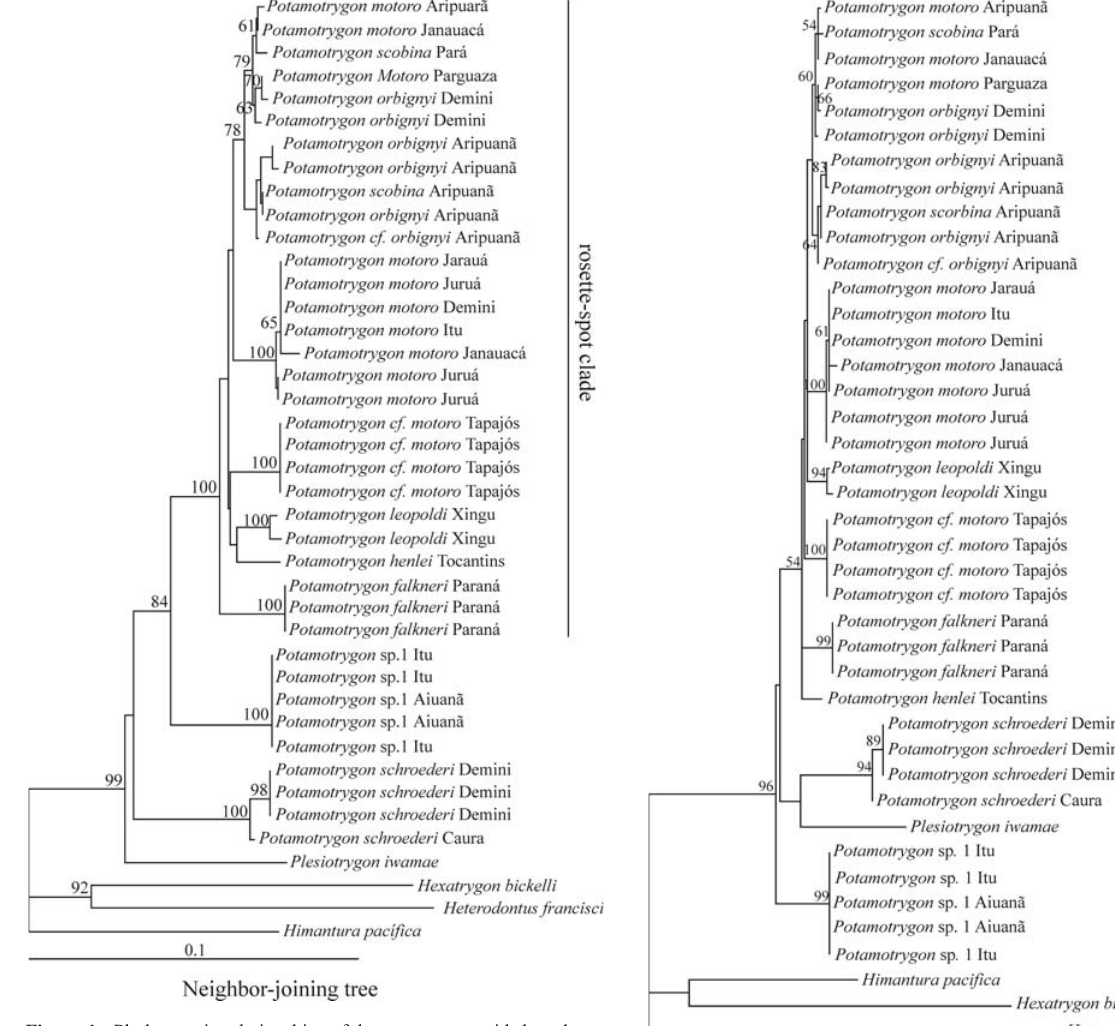
Figure 1 - Phylogenetic relationships of the potamotrygonids based on a Neighbor-Joining analyses of mitochondrial COI sequence data using K2P substitution model. Bootstrap values less than 50% were not shown. Plesiotrygon iwamae appears sister to all species of Potamotrygon . P. motoro , P. scobina , and P. orbignyi are non-monophyletic. The relation- ships among species of rosette-spot group are not well supported and branch lengths are short, evidence of a radiation.